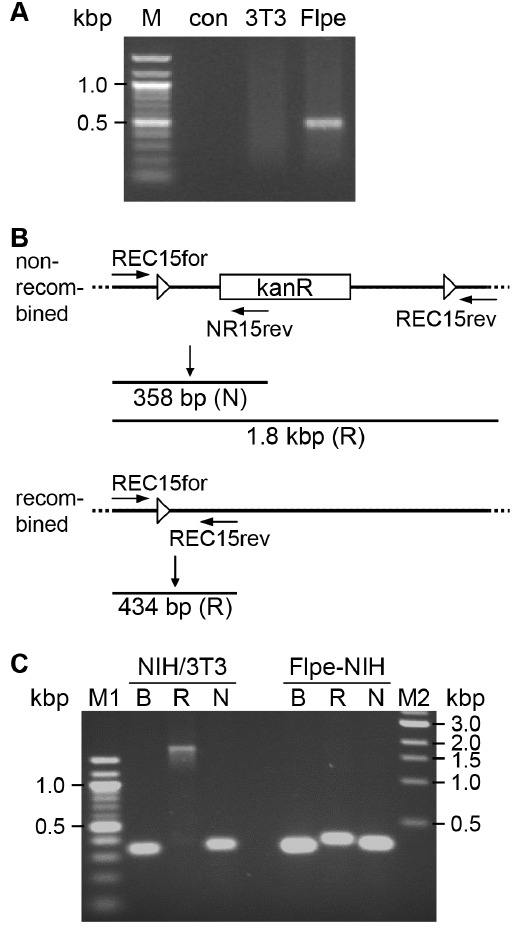
Figure 2. Flpe recombinase is expressed and functional. (A) Total RNA was isolated from NIH/3T3 (3T3) and Flpe-NIH cells (Flpe), reverse transcribed and PCRed using primers specific for the flpe gene. The control reaction (con) did not contain any template. M, 100 bp DNA ladder. (B) Schematic representation of the N and R reaction. For non- recombined pCP15, the R reaction results in a 1.8 kbp fragment, whereas the N reaction amplifies a 358 bp fragment. In recombined plasmids, the R reaction produces a 434 bp amplicon. (C) NIH/3T3 and Flpe-NIH cells were nucleofected with the plasmid pCP15. Cells were harvested at 1 dpt, total DNA was isolated and PCR-probed for Flpe- mediated recombination of pCP15. The recombination is probed by the R and the N reactions (R, N) as described above. The plasmid load was tested by the B reaction (B). M1, 100 bp DNA ladder; M2, 1 kbp DNA